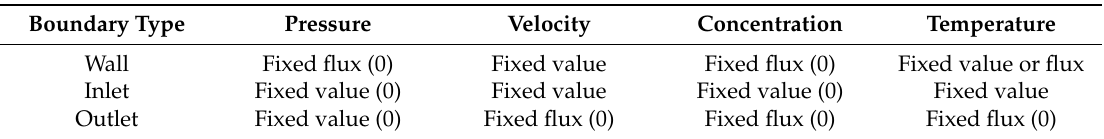
Table 1. Boundary conditions used in our numerical simulations. For more details about the boundary conditions, see